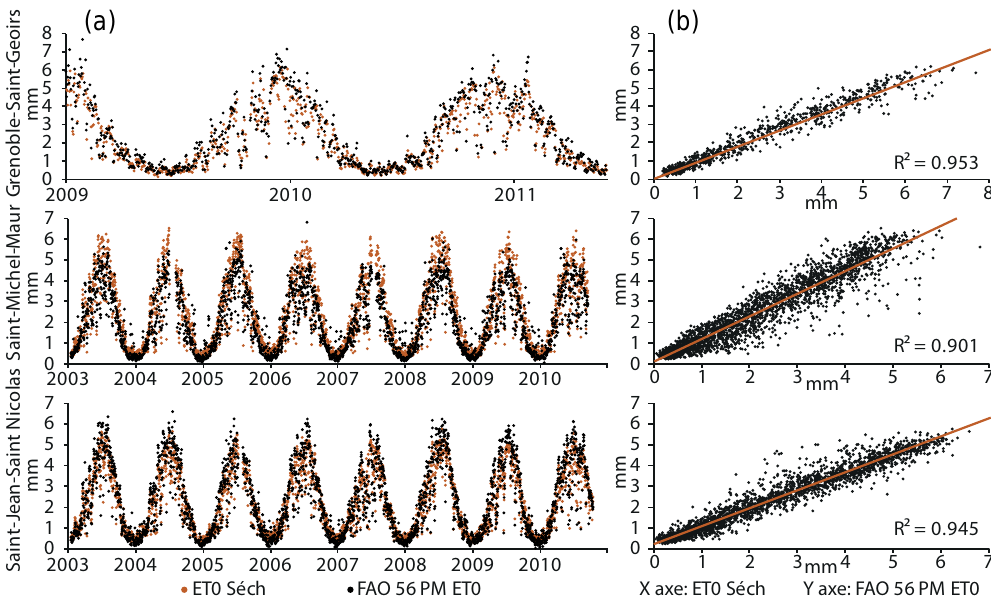
Figure 5. ET 0 regional calibration results at the three reference weather stations (Grenoble-Saint-Geoirs, Saint-Jean-Saint-Nicolas and Saint- Michel-Maur). (a) ET 0Séch and FAO-56 PM ET 0 as a function of time. (b) Linear regression between ET 0Séch ( x axis) and FAO-56 PM ET 0 ( y axis). ET 0Séch stands for ET 0 computed with the combination of calibrated ET 0 Penman–Monteith reduced-set method and calibrated R S modified Bristow–Campbell method.